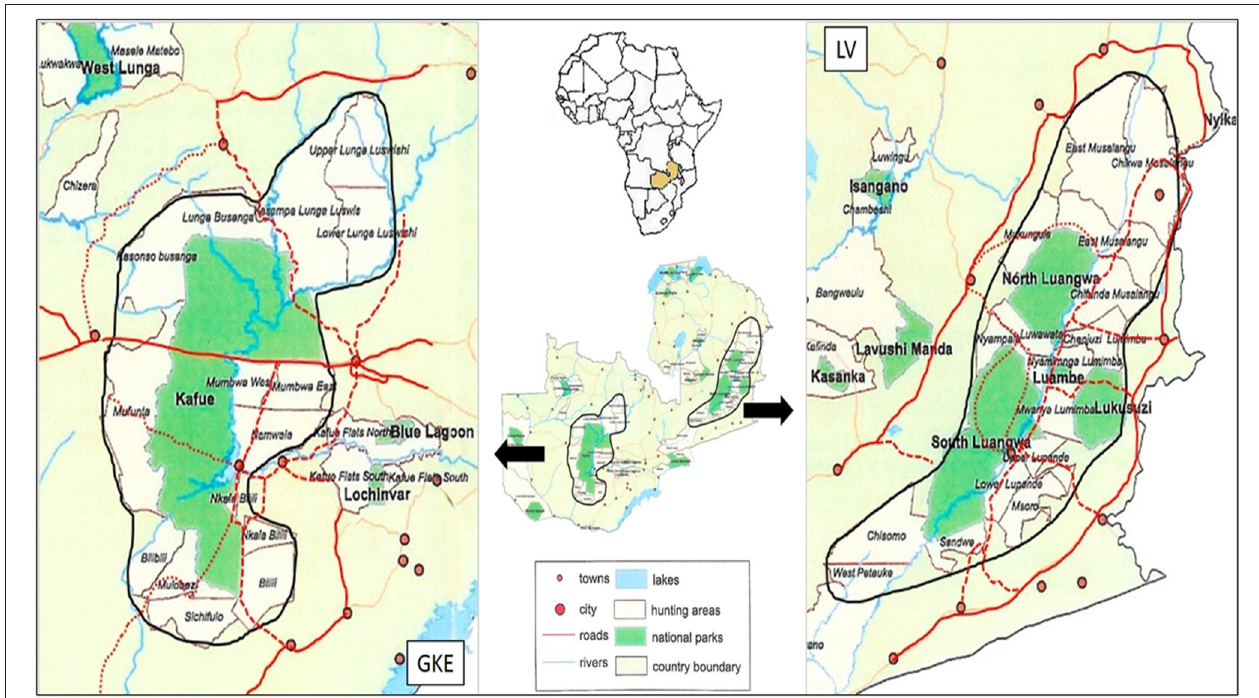
FIGURE 1 | Location map of Zambia showing the Luangwa Valley (LV) and the Greater Kafue Ecosystem (GKE). Enlarged maps illustrate the different designs of the two regions with respect to locations of NPs and GMAs. Shown are the main paved (solid red), main unpaved (dashed red) and minor unpaved (dotted red) roads in proximity to protected area boundaries. Not shown are networks of largely seasonal, unpaved roads located in NPs and GMAs.